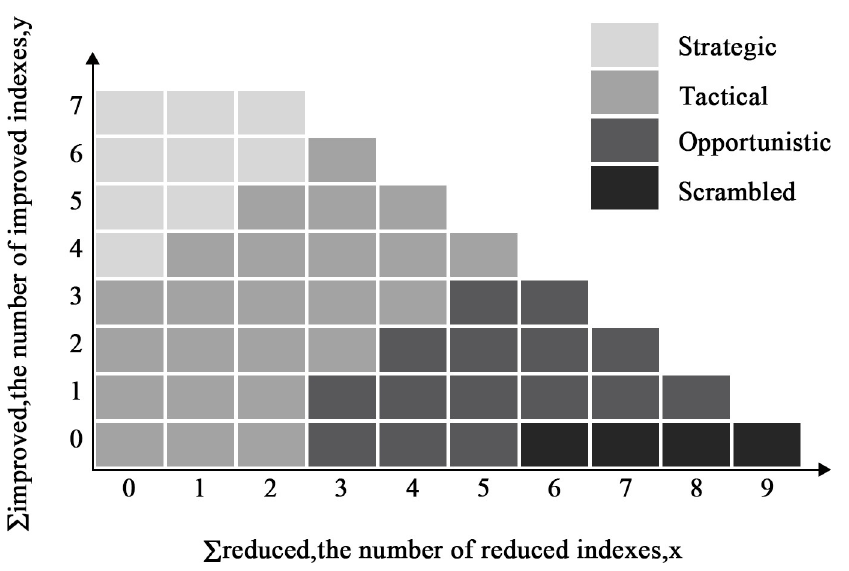
Fig 1. Relations between original CPC score and control mode (Hollnagel,